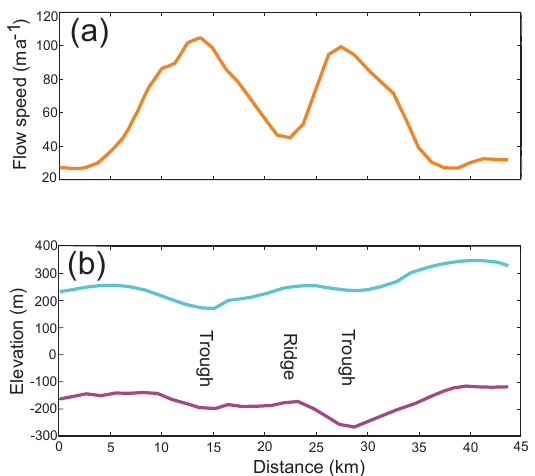
Figure 3. (a) Flow speed profile across a gateway 5km upstream of the grounding line (marked in Fig. 2). (b) Surface and bed elevations for the